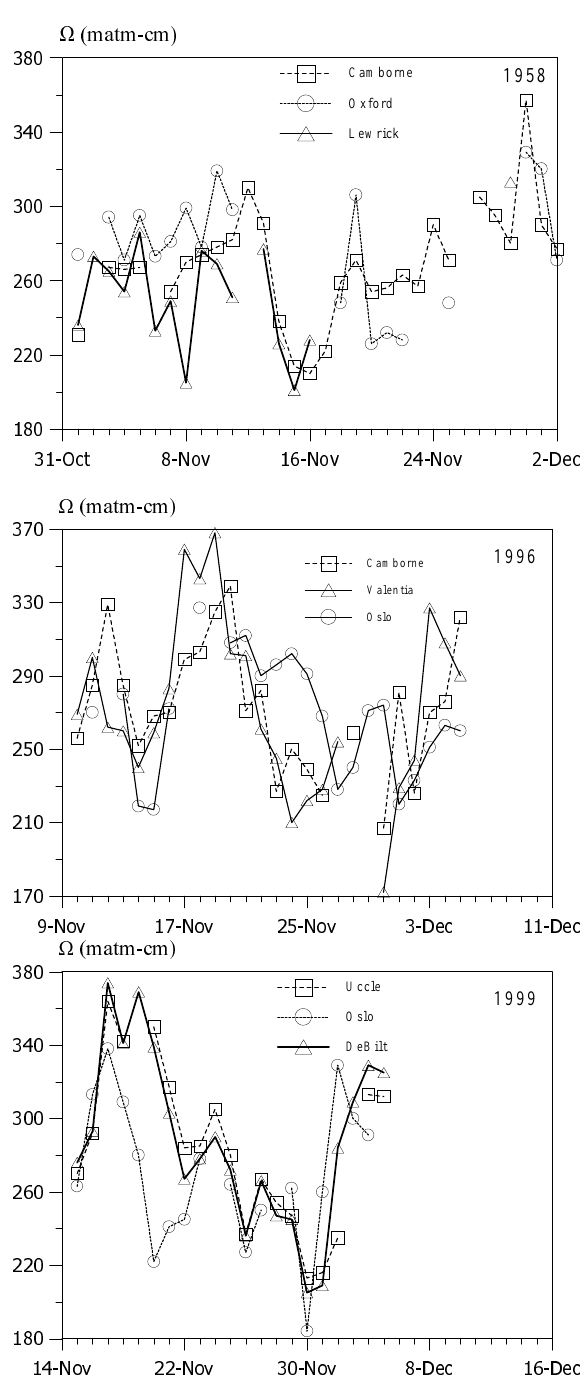
Fig. 4. Daily ozone values reported by a few stations during the ELO 3 episodes of 1958 (upper panel), 1996 (middle panel), and 1999 (lower panel).